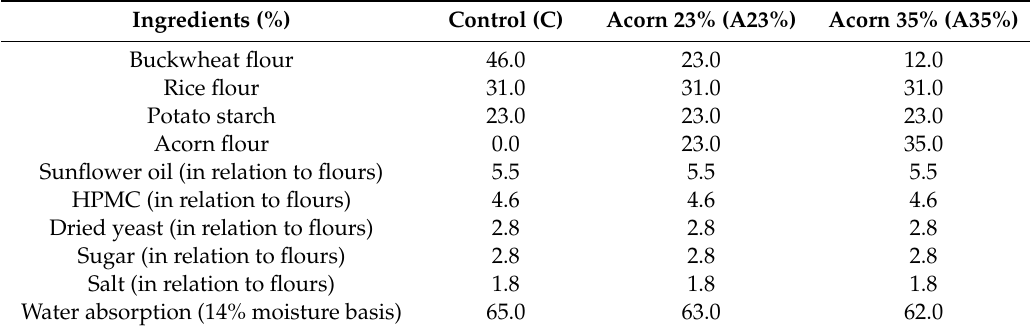
Table 1. Formulation of the gluten-free dough (GFD) samples and respective